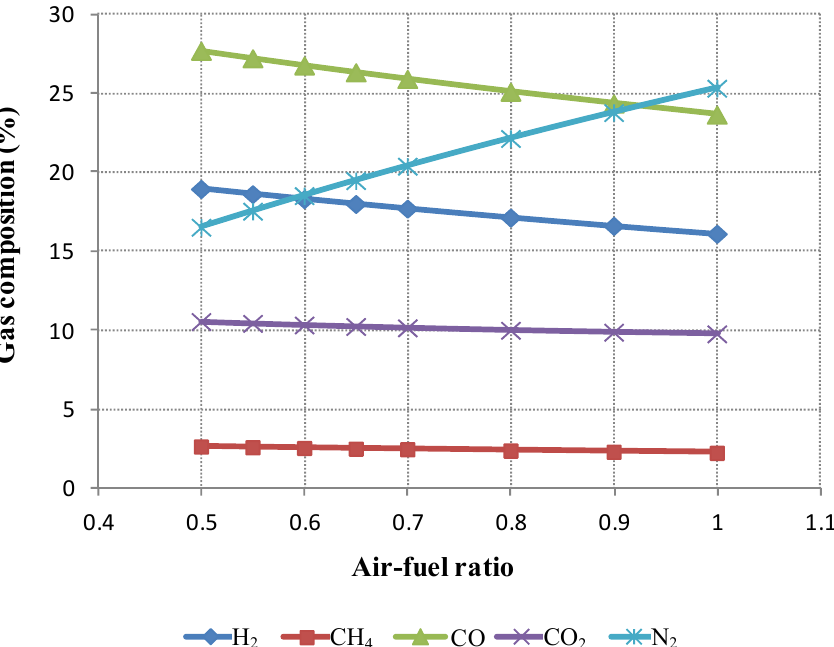
Figure 5. Effect of air-fuel ratio on syngas